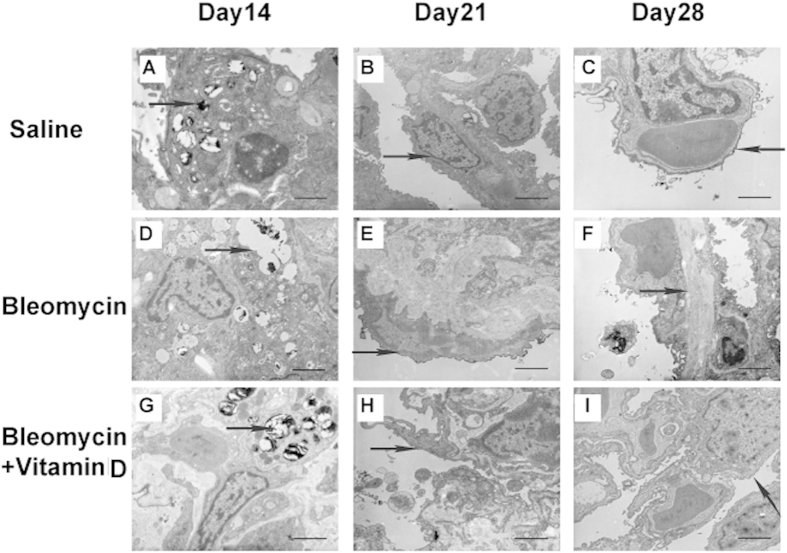
Representative TEM micrographs of the three groups.Saline Group: The alveolar space is patent and clean. Many lamellar bodies with concentric circles or parallel arrangements in the cytoplasm of AT II cells were observed (arrow (A)). The structures of type I alveolar epithelial (AT I) cells and AT II cells were integrated. Many short microvilli attached to the free surface of AT II cells were covered with pulmonary surfactant (PS; arrow, (B)). There were only thin layers of a basal film between the vascular endothelial cells and type I alveolar epithelial cells (arrow, (C)). Bars = 2 μm. Bleomycin Group: Increased numbers of lamellar bodies with obvious evacuation and vacuolation and fusion into macrovesicles were observed (arrows, (D)). Part of the microvilli fell off, and the numbers of lysosomes were increased (arrows, (E)). Significantly more collagen fibrils were disorganized and deposited in the extracellular matrix. The basement membrane between the vascular endothelial cells and type I alveolar epithelial cells was thickened and filled with collagen fibrils (arrows, (F)). Bars = 2 μm. Bleomycin+vitamin D Group: The lamellar bodies showed no evidence of evacuation, vacuolation or cavitation (arrows, (G)). The mitochondria were not swollen and the number of lysosomes did not increase (arrows, (H)), and the microvilli were well-preserved (H). The basement membrane was not significantly thickened on day 28 (arrows, (I)). Bars = 2 μm